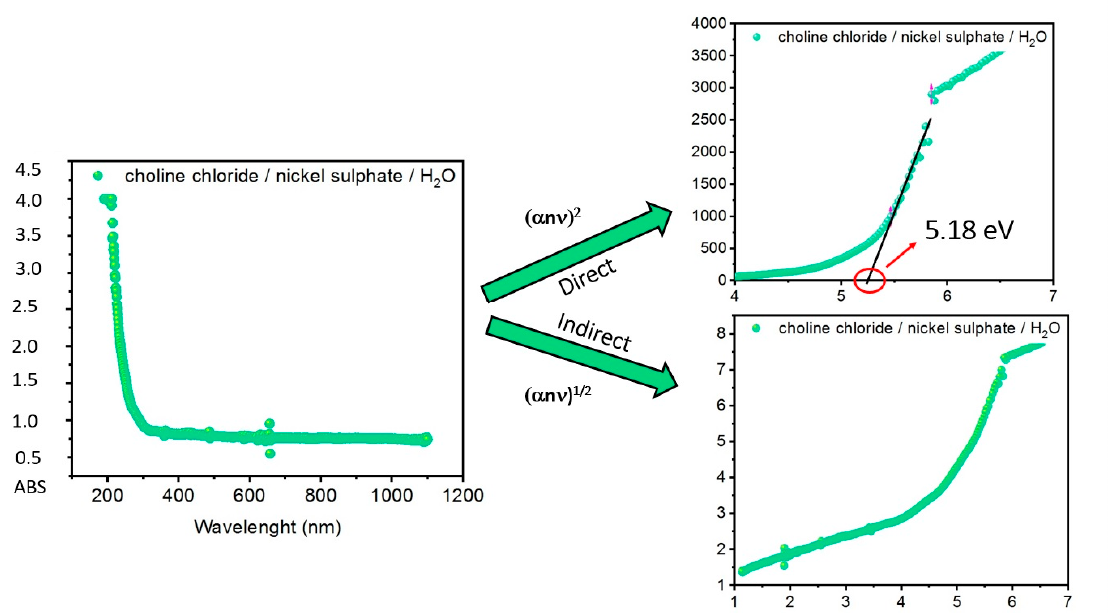
Figure 2. UV–VIS spectrum and Tauc plots for indirect and direct transition of System 1.